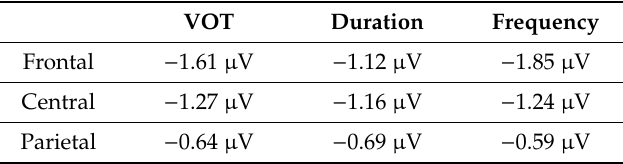
Table 3. Mean MMNs amplitude in children with dyslexia averaged across sessions and across large and small deviant stimuli on Voice Onset Time (VOT), duration, and frequency at Frontal, Central, and Parietal sites. VOT Duration Frequency Frontal − 1.61 µ V − 1.12 µ V − 1.85 µ V Central − 1.27 µ V − 1.16 µ V − 1.24 µ V Parietal − 0.64 µ V − 0.69 µ V − 0.59 µ